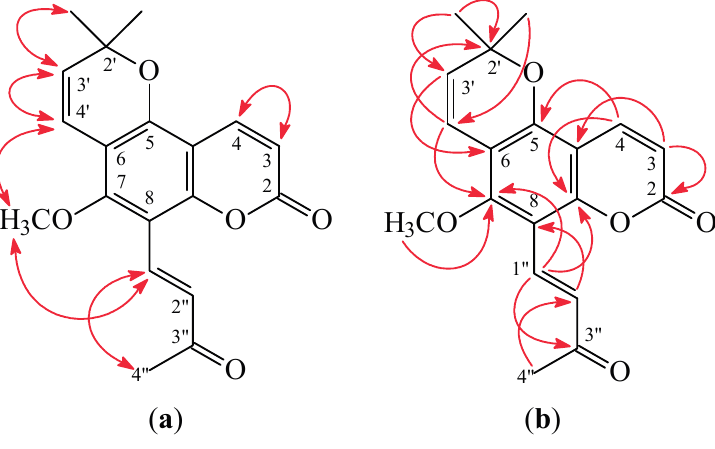
Figure 4. Key NOESY ( a ) and HMBC ( b ) correlations of 2